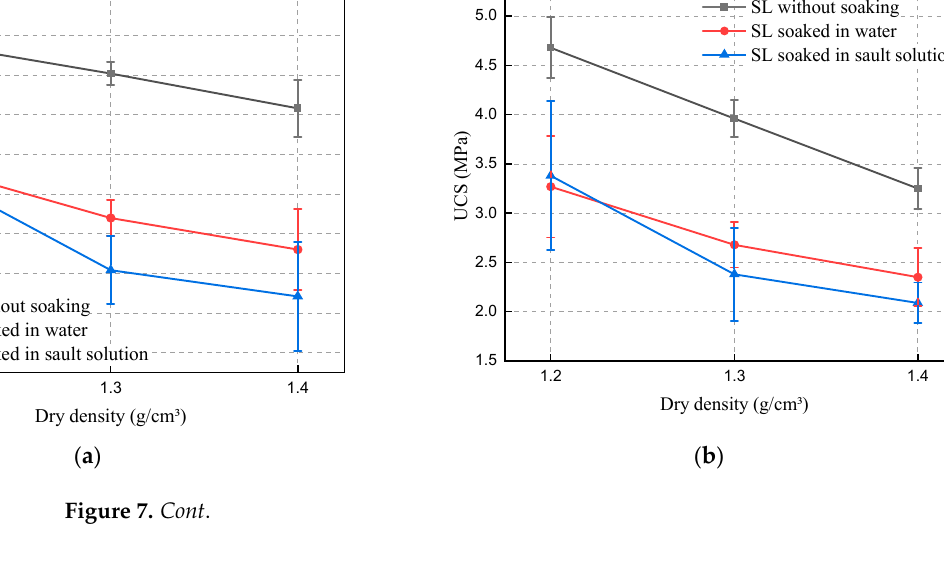
( c ) Figure 7. The effect of the service environments on compressive strength. ( a ) 5% water content, ( b ) 10% water content, ( c ) 15% water content. After 56 days of immersion, the compressive strength of the solidified soil decreased by 0.9–2.6 MPa, still retaining a compressive strength of 0.91–3.87 MPa. The gel generated by the reaction of the polymer with water is not subject to the corrosion of Na 2 SO 4 . In this respect, the corrosion resistance of permeable polymer is better than that of cement slurry [41]. By comparing the reinforcement effect with other chemical pastes, it was found that the reinforcement effect of the SL after soaking is still twice that of the loess with 9% ce- ment content [42], 4.33 times that of the loess treated by F 1 ion curing agent [43], 5 times that of the loess treated by CaCl 2 , 3.83–15.7 times of the UL. Through an immersion test and a series of data comparisons, it was found that the compressive strength of the SL after immersion was stronger than the reinforcement ef- fect of the above materials without immersion, and the disadvantages of traditional ce- ment slurry, fly ash, and quicklime, which is susceptible to salt corrosion, were solved [44], therefore, the permeable polymer has better durability and reinforcement effect in loess areas. 3.4. Sensitivity Analysis